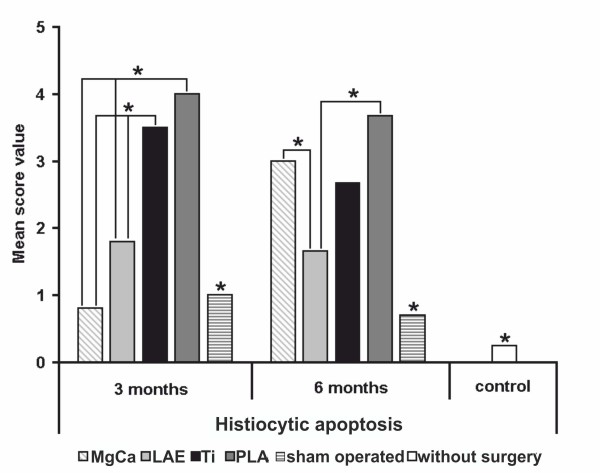
Score values of histiocytic apoptosis for all examined groups (* = p < 0.05). Three months: PLA and Ti showed significant higher values than MgCa, LAE, sham operated and control group; Six months: MgCa showed a distinct increase, the values for PLA, Ti, LAE and for the sham operated group decreased. MgCa = MgCa0.8, LAE = LAE442, PLA = poly-96L/4D-lactide, Ti = TiAl6V4, sham operated = surgery without implant material, control = no surgery on the limb.